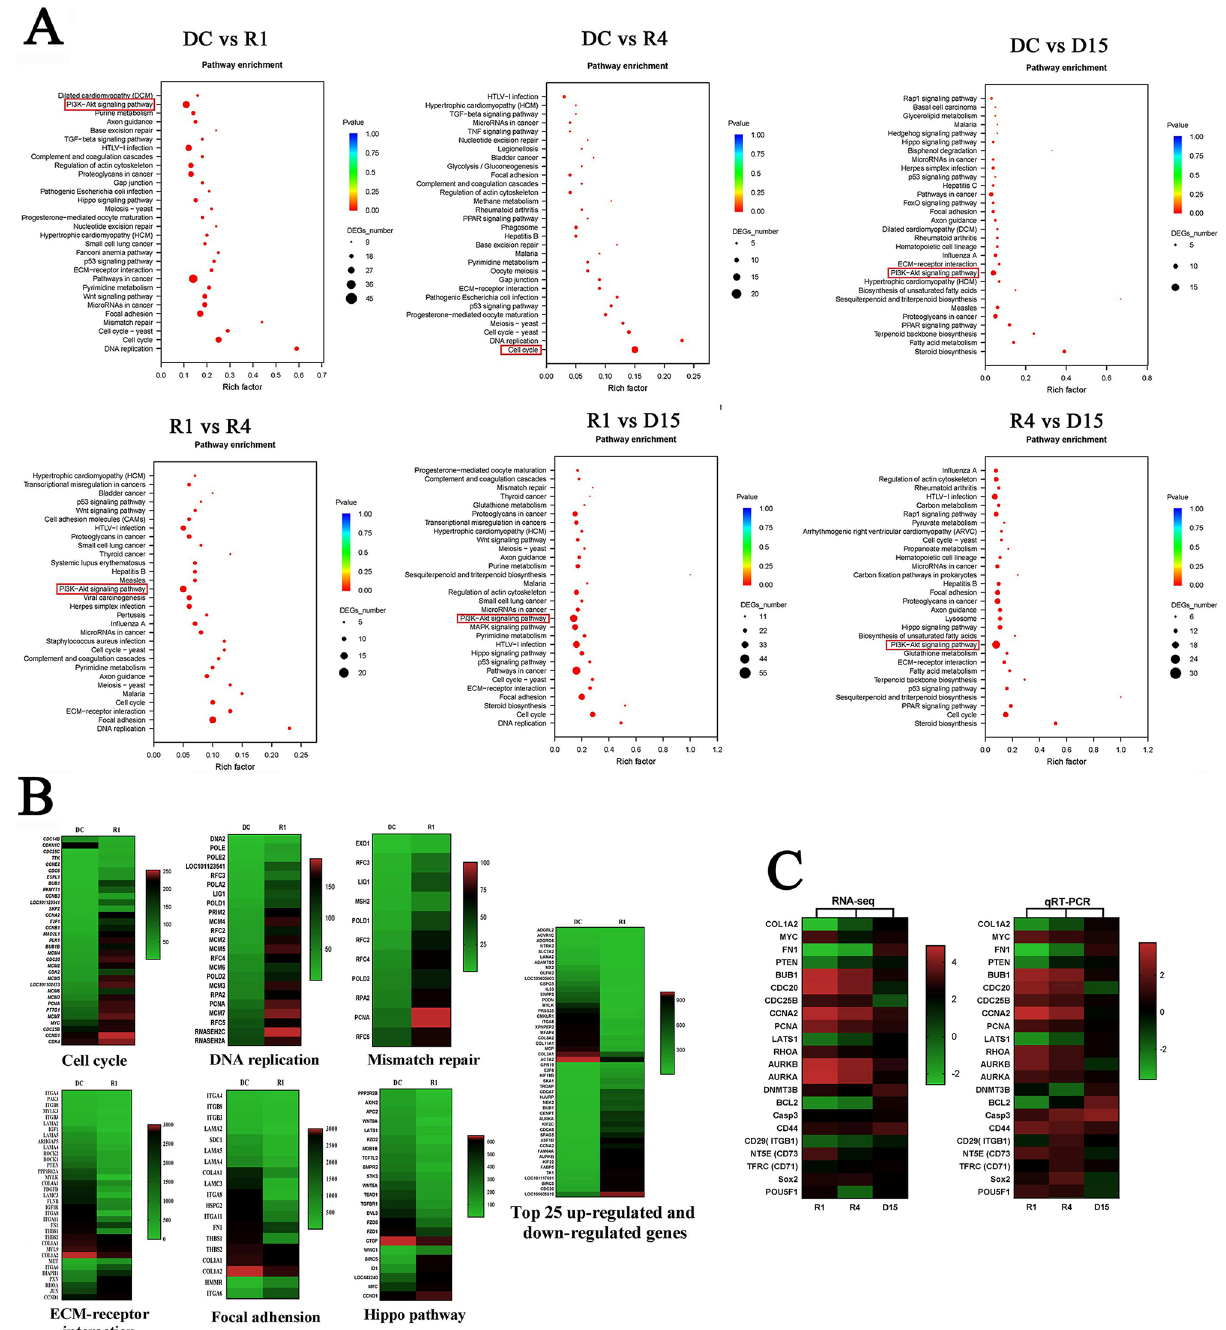
Figure 9. Characteristic comparisons of RNA-Seq dataset among four groups. ( A ) Enriched pathways detection among four group’s DEGs by KEGG analysis. The pathways labeled by red boxes indicate the one enriched the most DEGs compared in two groups. ( B ) DEGs involved in Cell cycle, DNA replication, Mismatch repair, ECM- receptor interaction, Focal adhesion, and Hippo pathway were exhibited, as well as 25 top up-regulated and down-regulated genes between C1 and R1. ( C ) Validation of RNA-Seq data by qRT-PCR. The left profile shows mRNA expression patterns of 22 representative genes detected by RNA-Seq, the right one is the corresponding verification results by qRT-PCR. EF1α was employed as an internal